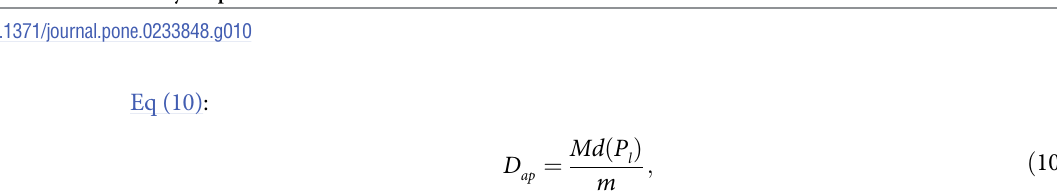
Fig 10. Morphology (a) has the modules indicated by green arrows horizontally reflected by the modules indicated by orange arrows; (b) has no modules reflected; (c) has the module indicated by the orange arrow vertically reflected by the modules indicated by the green arrow, but no reflection for the module indicated by the pink arrow.